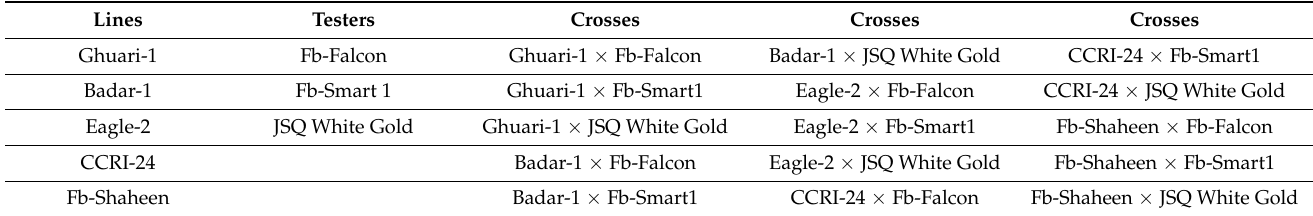
Table 1. List of lines, testers and their cross combinations used in experiment.